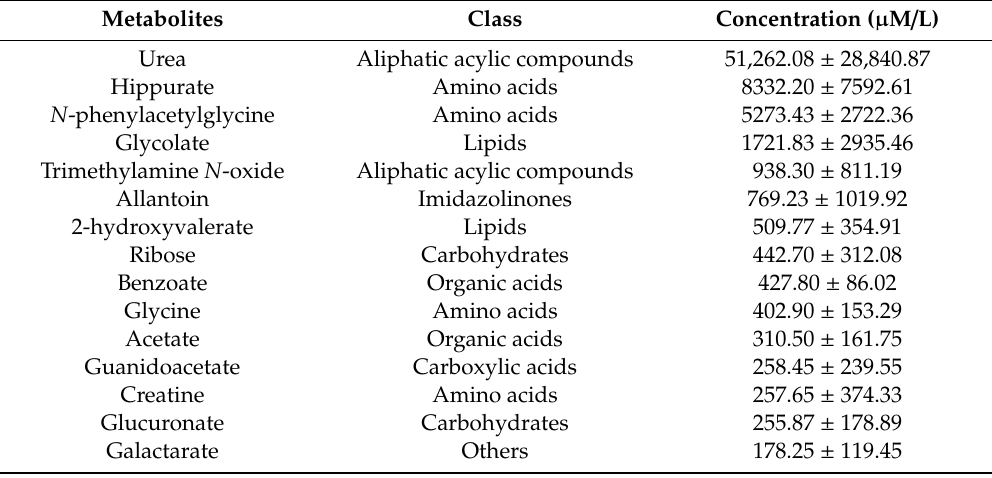
Table 3. Top 30 concentration (mean ± standard deviation) of metabolites quantified ( n ≥ 3) in urine by 1 H-NMR spectroscopy of Hanwoo steers.